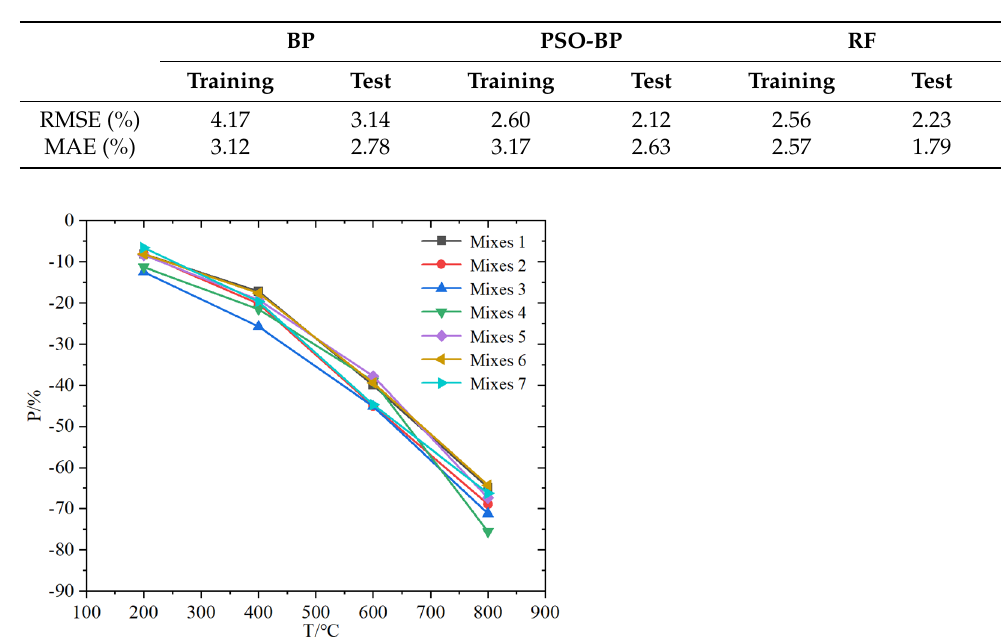
Figure 9. Relationship between temperature and loss of compressive strength of concrete after high temperature.